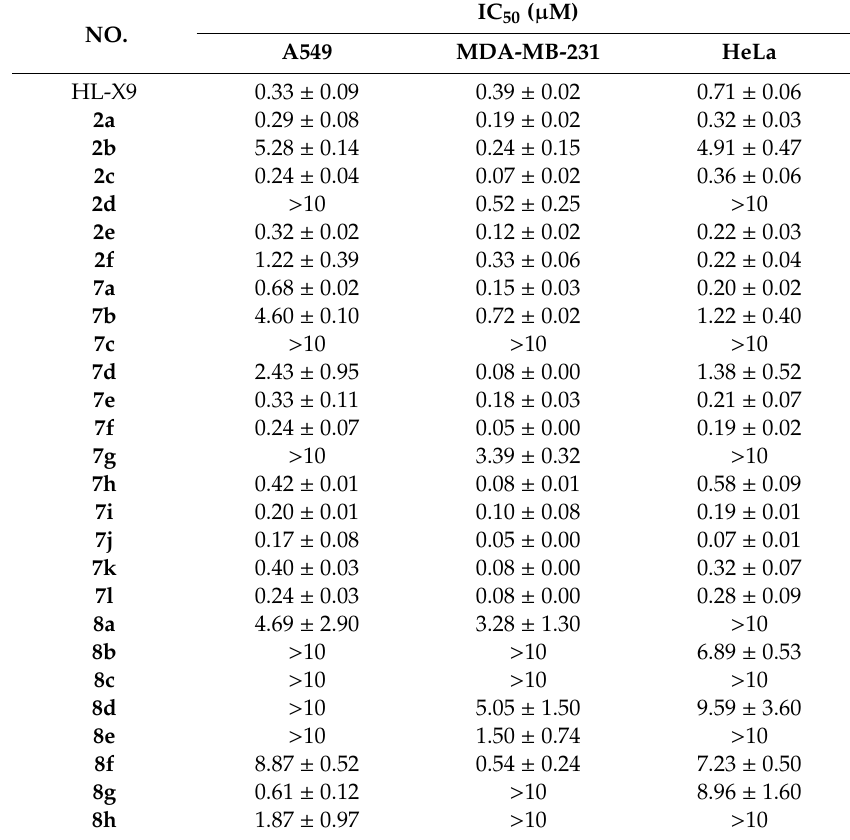
Table 1. Antiproliferation activity of sulfonylazaspirodienones against cancer cell lines in